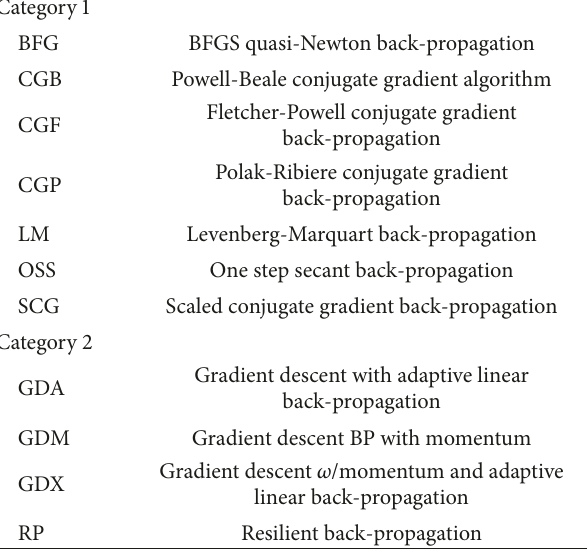
Table 1: Back-propagation training